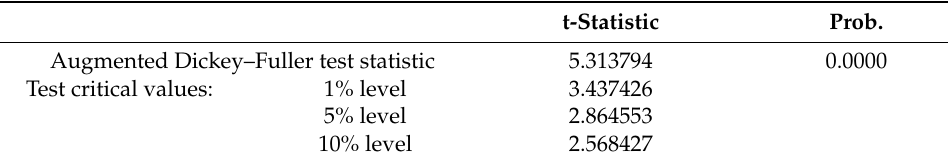
Table 1. Augmented Dickey–Fuller test for unit root.